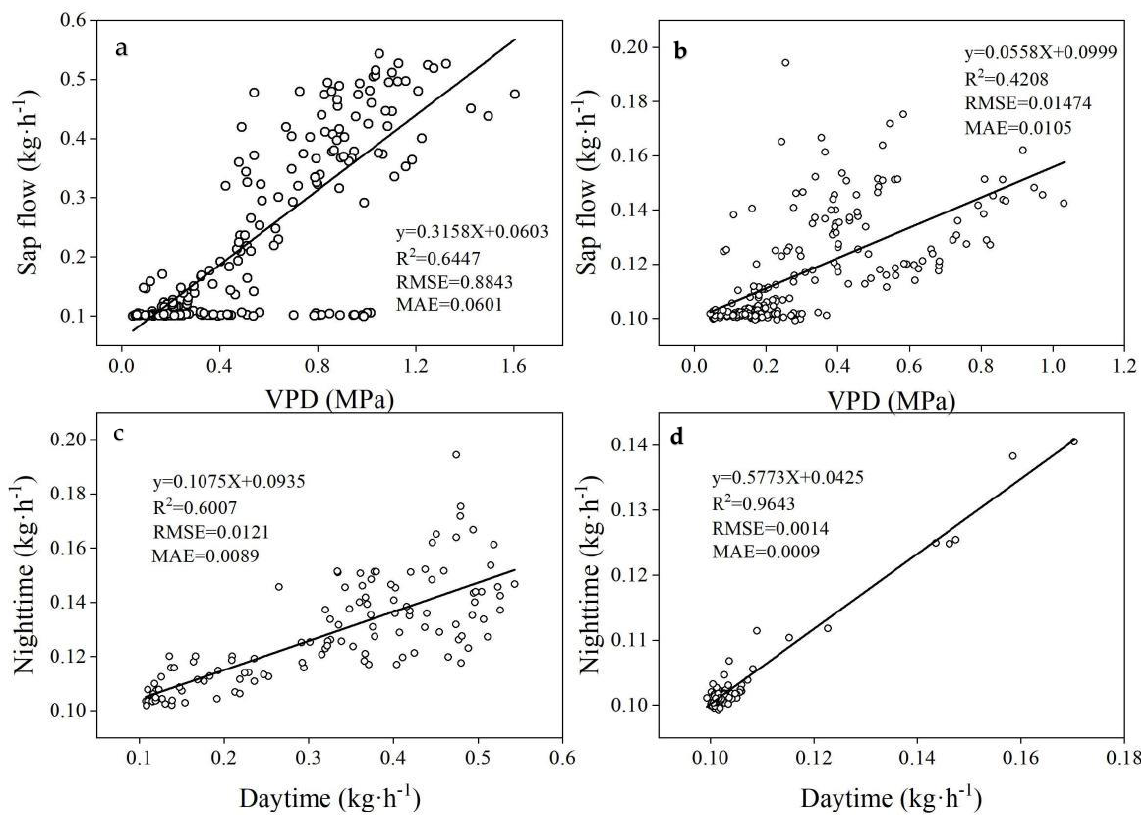
Figure 9. Relationship between VPD and sap flow of golden pear. ( a ) Linear regression between daytime sap flow and VPD. ( b ) Linear regression between night sap flow and VPD. ( c ) and ( d ) are the relationship between daytime and nighttime sap flow in the growing season and non-growing season, respectively. The significance level was p < 0.05. RMSE is root mean square error, MAE is mean absolute value error.